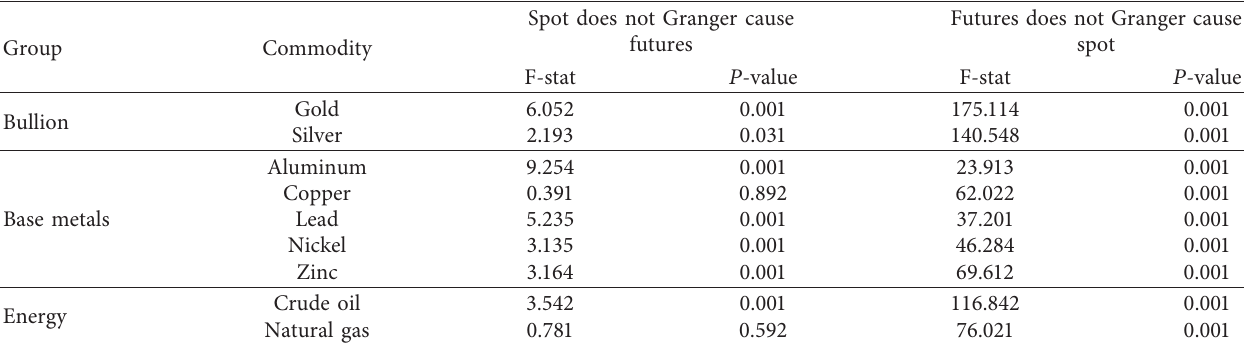
Table 7: Granger causality test of spot and futures returns for the selected